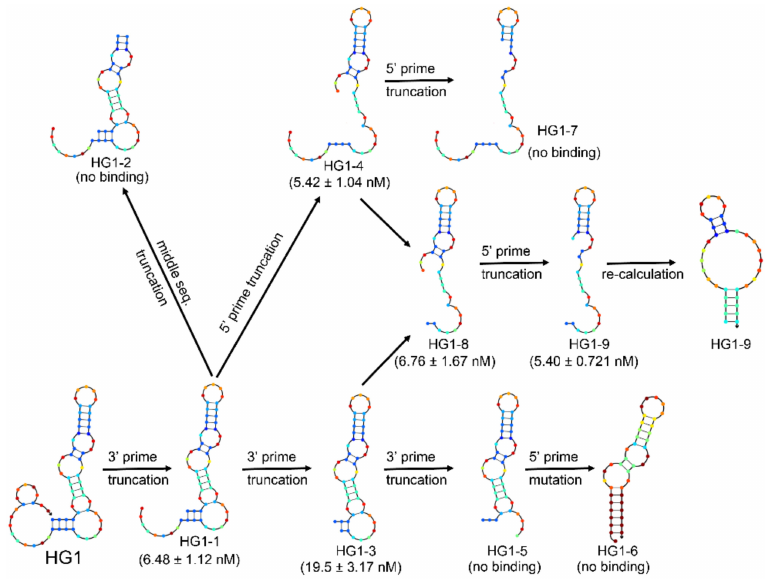
Figure 2. Truncation of HG1. The secondary structure of HG1 was predicted by the Nupack program and K d of each sequence was given in